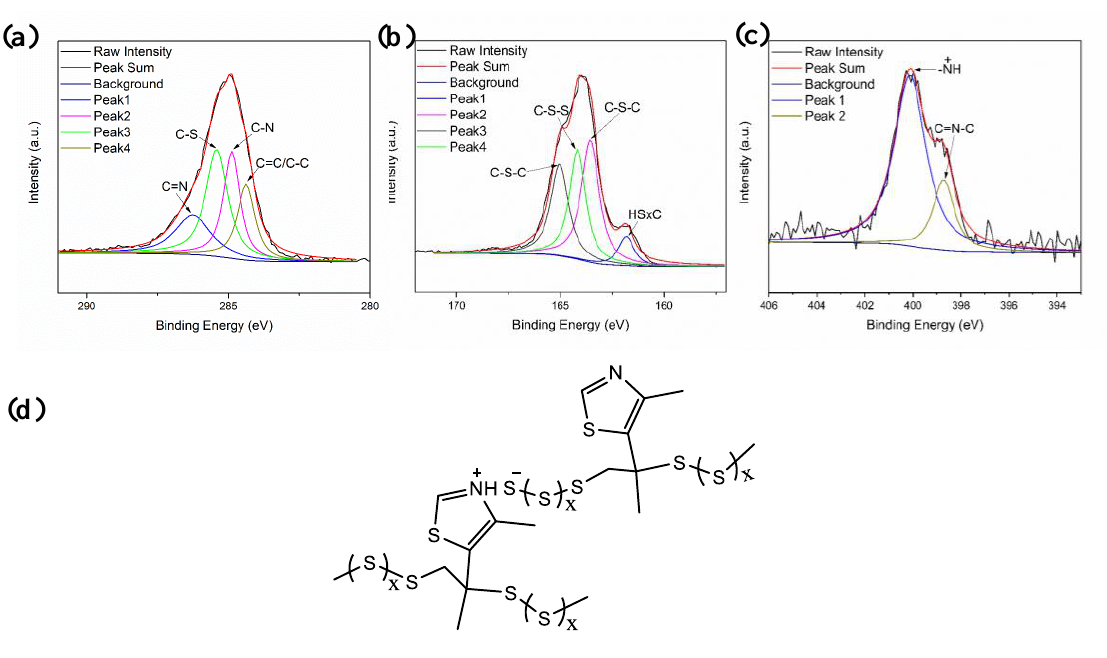
Figure 2. High-resolution ( a ) C1s, ( b ) S2p, and ( c ) N1s XPS spectra of poly(S-MVT) (15% MVT). The black curves are the